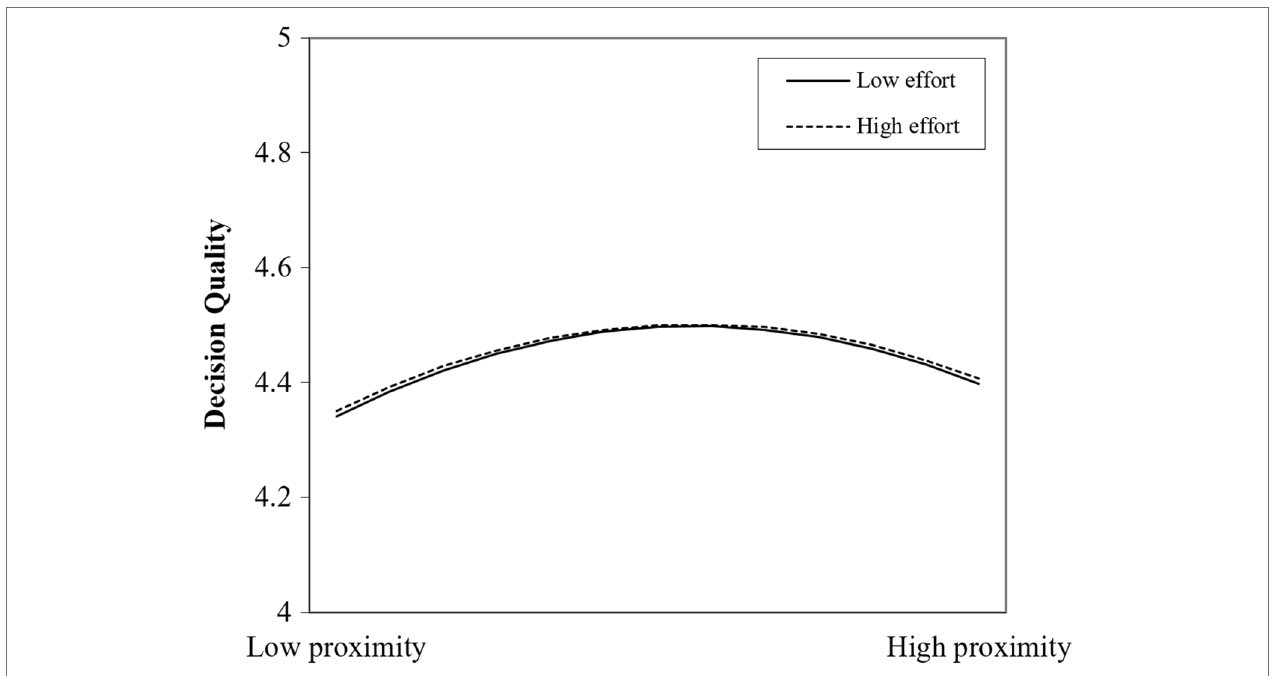
FIGURE 3 | Moderating effects of evaluation efforts on cognitive proximity and decision